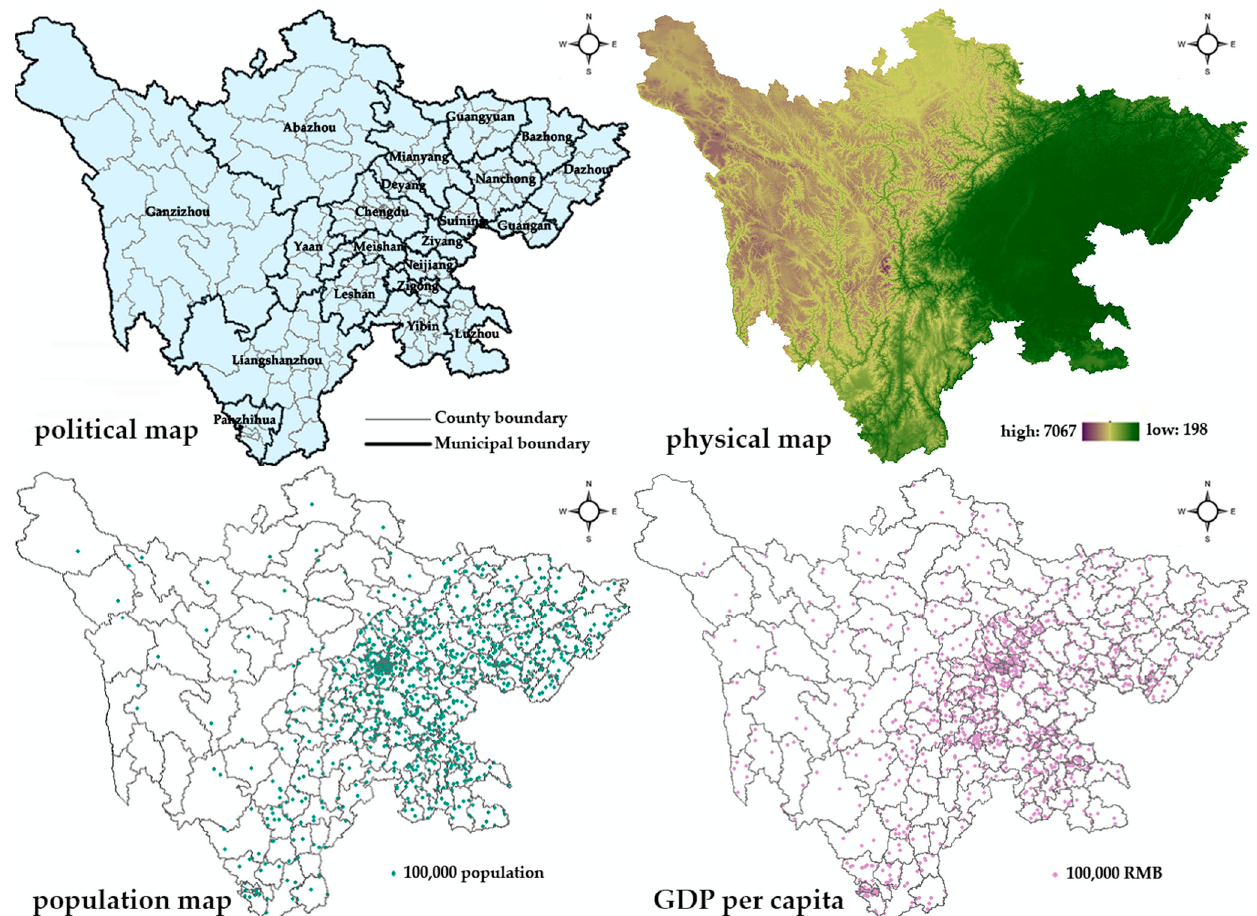
Figure 1. The map of Sichuan. The source of shapefiles was a public database, National Nature Resources and Geospatial basic information database of PRC (http://www.geodata.cn/) (accessed on 15 August 2021). Those shapefiles were under license without need for permission.